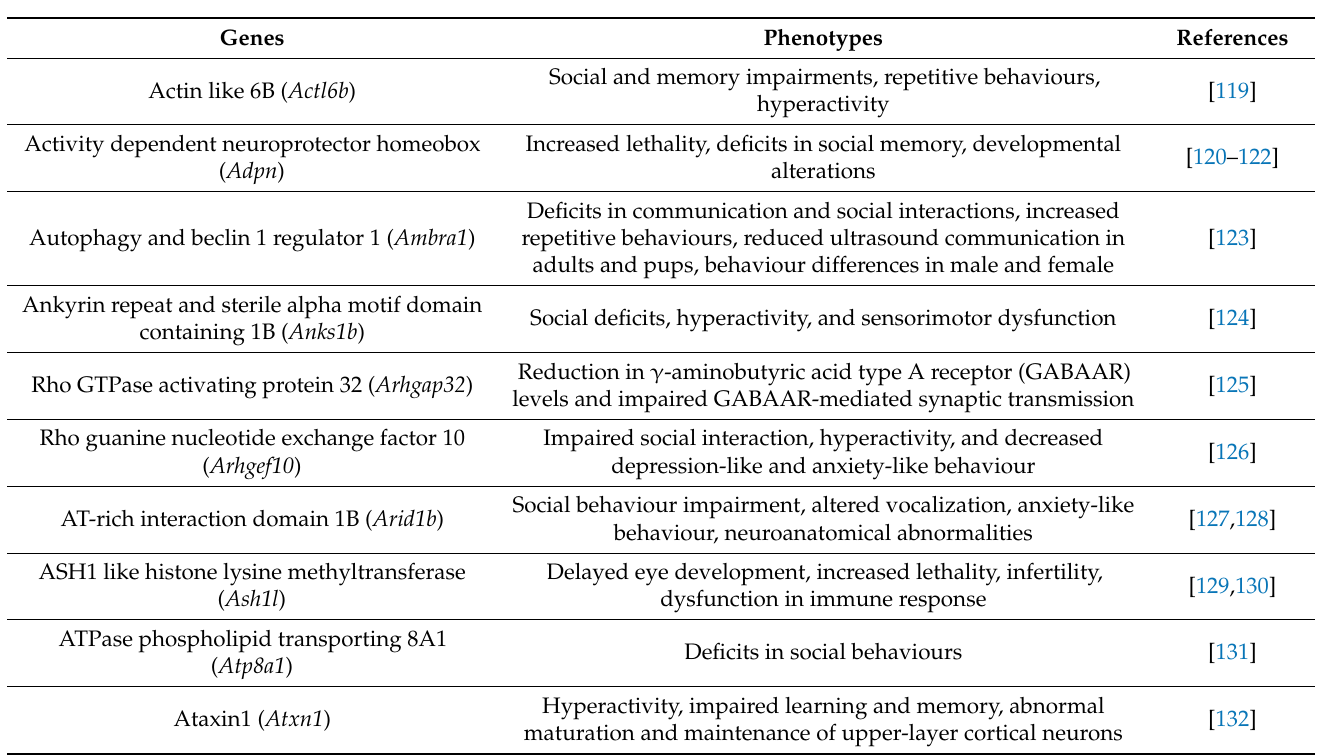
Table 6. Mouse models of ASD and observed phenotypes. The main genes and corresponding phenotypes observed in ASD mouse models are